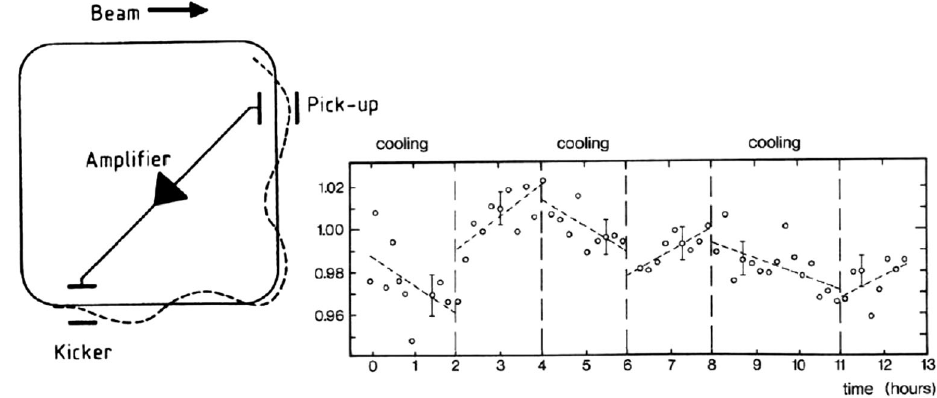
FIG. 18. First observation of stochastic cooling.